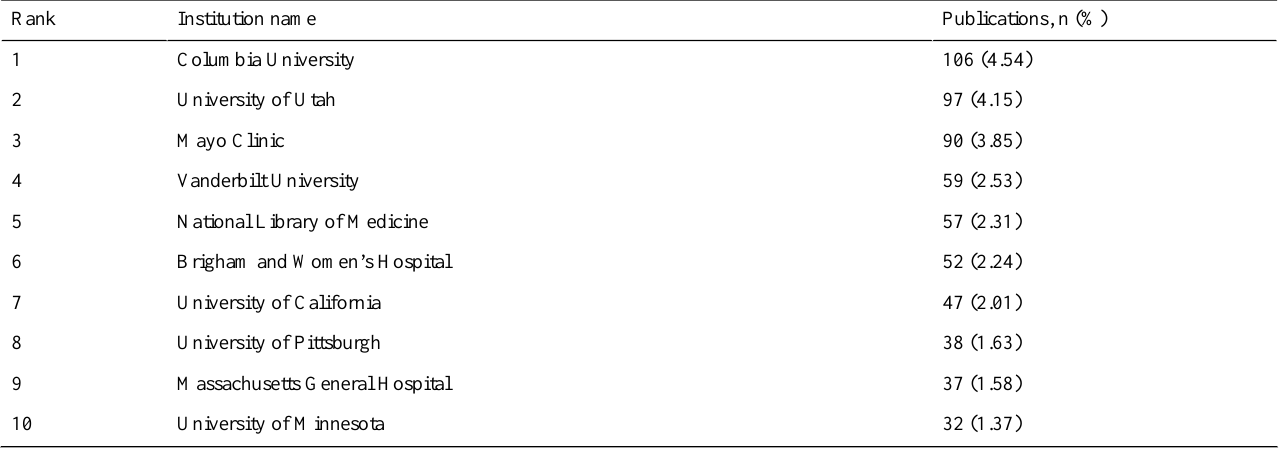
Table 5. Ranking of institutions to which the first authors belonged